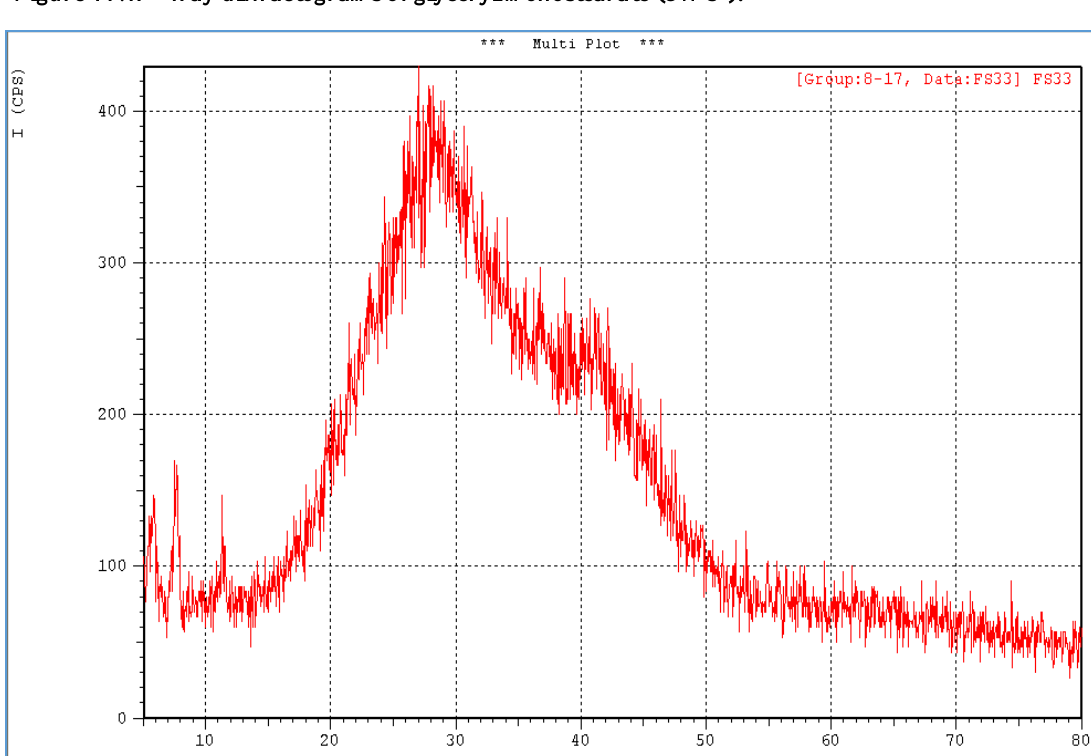
Figure 12 . X – Ray diffractograms of darifenacin hydrobromide loaded